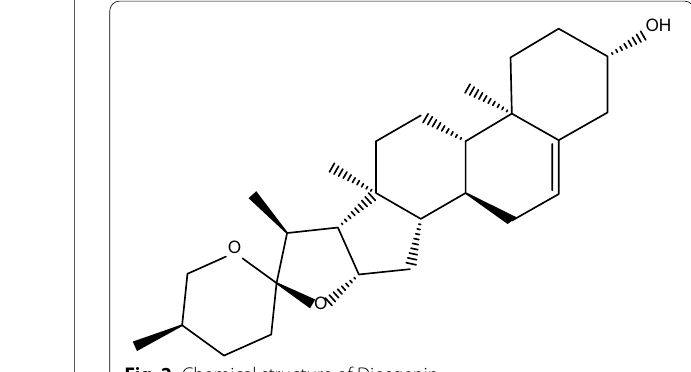
Fig. 1 Plant material of Trigonella foenum-graecum Seeds Fig. 2 Chemical structure of